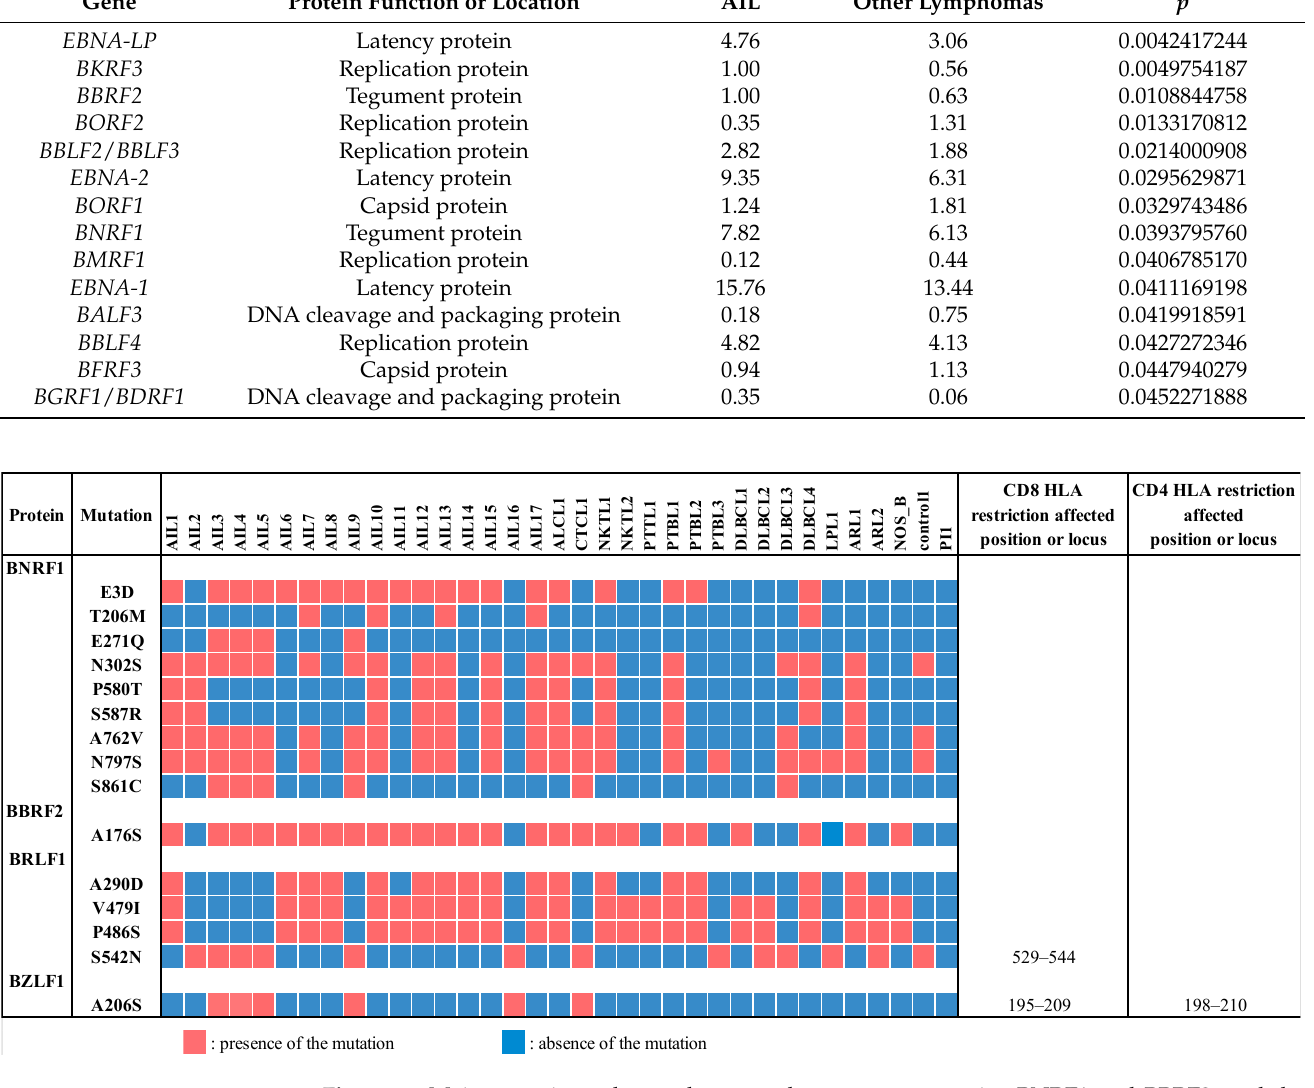
Figure 8. Main mutations observed among the tegument proteins BNRF1 and BBRF2, and the transcriptional activators BRLF1 and BZLF1. The CD4 and CD8 HLA restriction positions affected by the mutations are reported. For each protein, some mutations (not mentioned here) were present in all samples, including Control1 and PI1 (BNRF1 E36Q, C736F, and F1110S, BRLF1 A377E). Such variations were considered as geographically restricted. Mutations of AIL18, which is an EBV-2, are not reported. Table 5. Comparison of the Mean Number of Non-Synonymous Mutations/Gene Between the EBV “AITL” Strains and the “Other Lymphoma” Strains by the Mann-Whitney Test. Only Genes for Which p < 0.05 Were Reported.